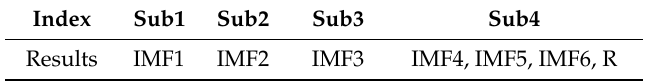
Table 3. The new subsequence after being processed by empirical mode decomposition (EMD).